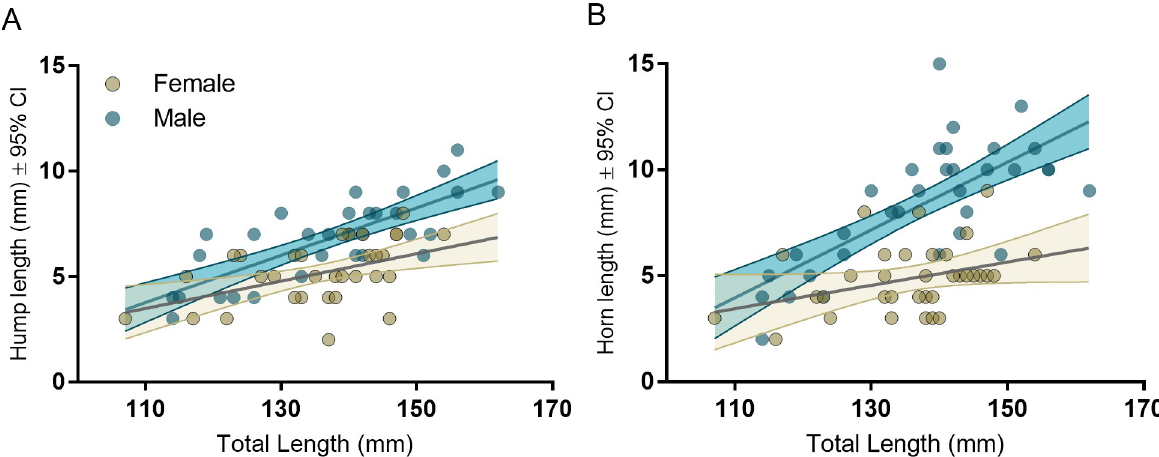
PLOS ONE | https://doi.org/10.1371/journal.pone.0240294 October 8,